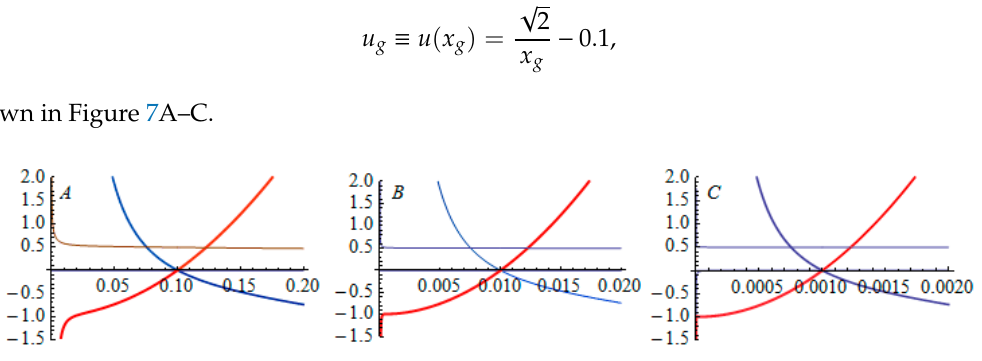
√ ux ( b ). 2 − 0.1 ( b gg